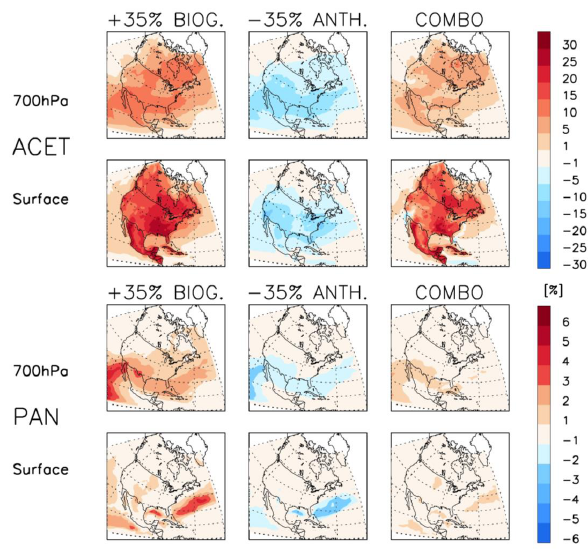
Fig. 7. Sensitivity of atmospheric acetone and PAN to biogenic Figure 7. Sensitivity of atmospheric acetone and PAN to biogenic and anthropogenic source 2 and anthropogenic source changes in North America during Au- changes in North America during August. Shown are the percent changes due to a 35% increase 3 gust. Shown are the percent changes due to a 35% increase in pri- in primary + secondary biogenic acetone sources (+35% BIOG), a 35% decrease in primary + 4 mary + secondary biogenic acetone sources ( + 35% BIOG), a 35% secondary anthropogenic sources (-35% ANTH), and the combined effect of the two (COMBO). 5 decrease in primary + secondary anthropogenic sources ( − 35% ANTH), and the combined effect of the two (COMBO). Note dif- Note differing color bars for acetone and PAN. 6 fering color bars for acetone and